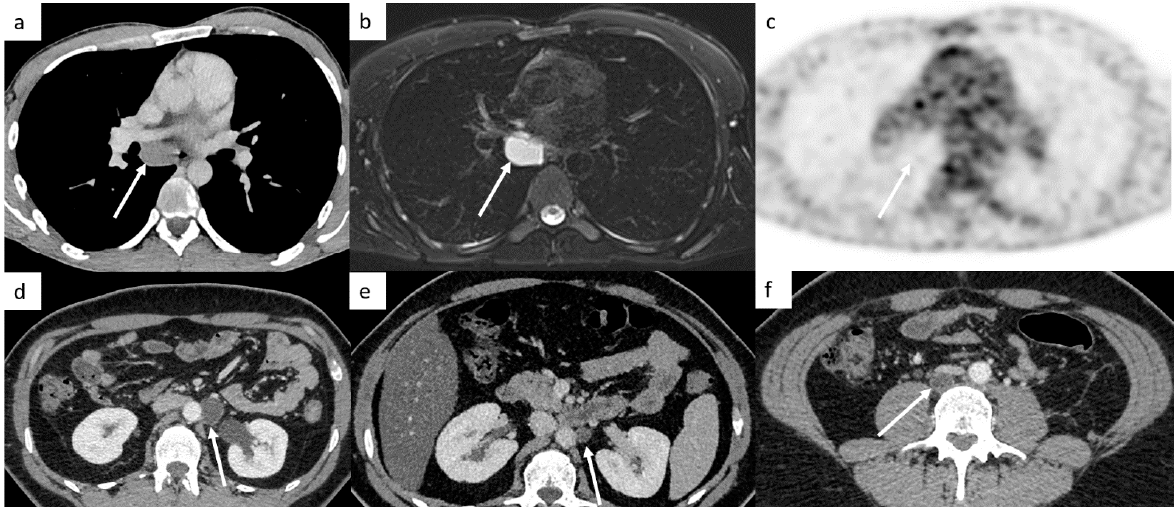
Figure 7. False-positive diagnoses. Thoracic CT shows a low-density mass below the carina in the middle mediastinum ( a ). A metastatic lymph node was suspected; however, this patient did not have any retroperitoneal lymph nodes. An MRI shows a well-circumscribed mass below the carina that appears hyperintense on T1-weighted images, hyperintense on T2-weighted images ( b ), without hypersignal on diffusion-weighted images. The FDG-PET CT confirms the absence of increased activity in this mass ( c ). It is a bronchogenic cyst. Post-surgical abdominal CT demonstrates a left paraaortic lymphocele ( d ) decreasing in size 3 months later, ( e ) but two years later, a low-density retrocaval mass appeared corresponding to teratoma ( f ). It shows that it can be difficult to differentiate teratoma from lymphocele, especially without prior CT to assess